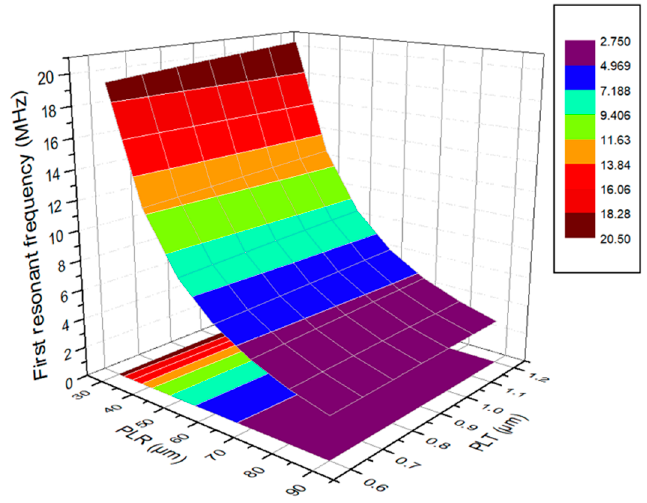
Figure 5. PMUT frequency vs. parameter plot.